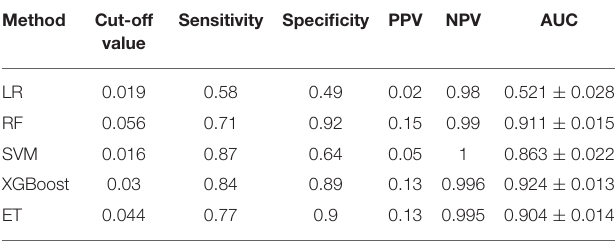
TABLE 4 | Performance of models. Method